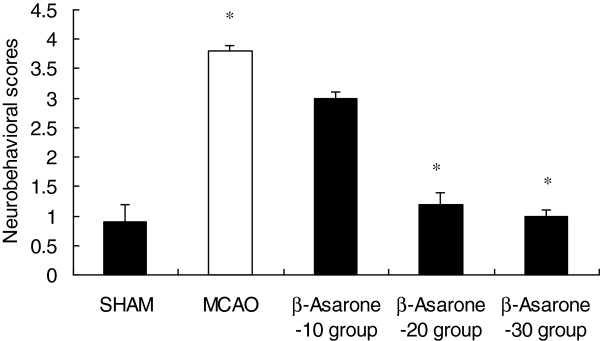
Effect of β-Asarone on the development of behavioral abnormalities after middle cerebral artery occlusion. Values are shown as means ± SEM. *p < 0.05 vs. MCAO group, **p < 0.01 vs. MCAO group. (FSHAM =17.642, dfSHAM=11, pSHAM=0.001, Fβ-Asarone−10=2.252, dfβ-Asarone−10=11, pβ-Asarone−10=0.162, Fβ-Asarone−20=16.396, dfβ-Asarone−20=11, pβ-Asarone-20 = 0.01, Fβ-Asarone−30=22.738, dfSHAM=11, pSHAM=0.02).